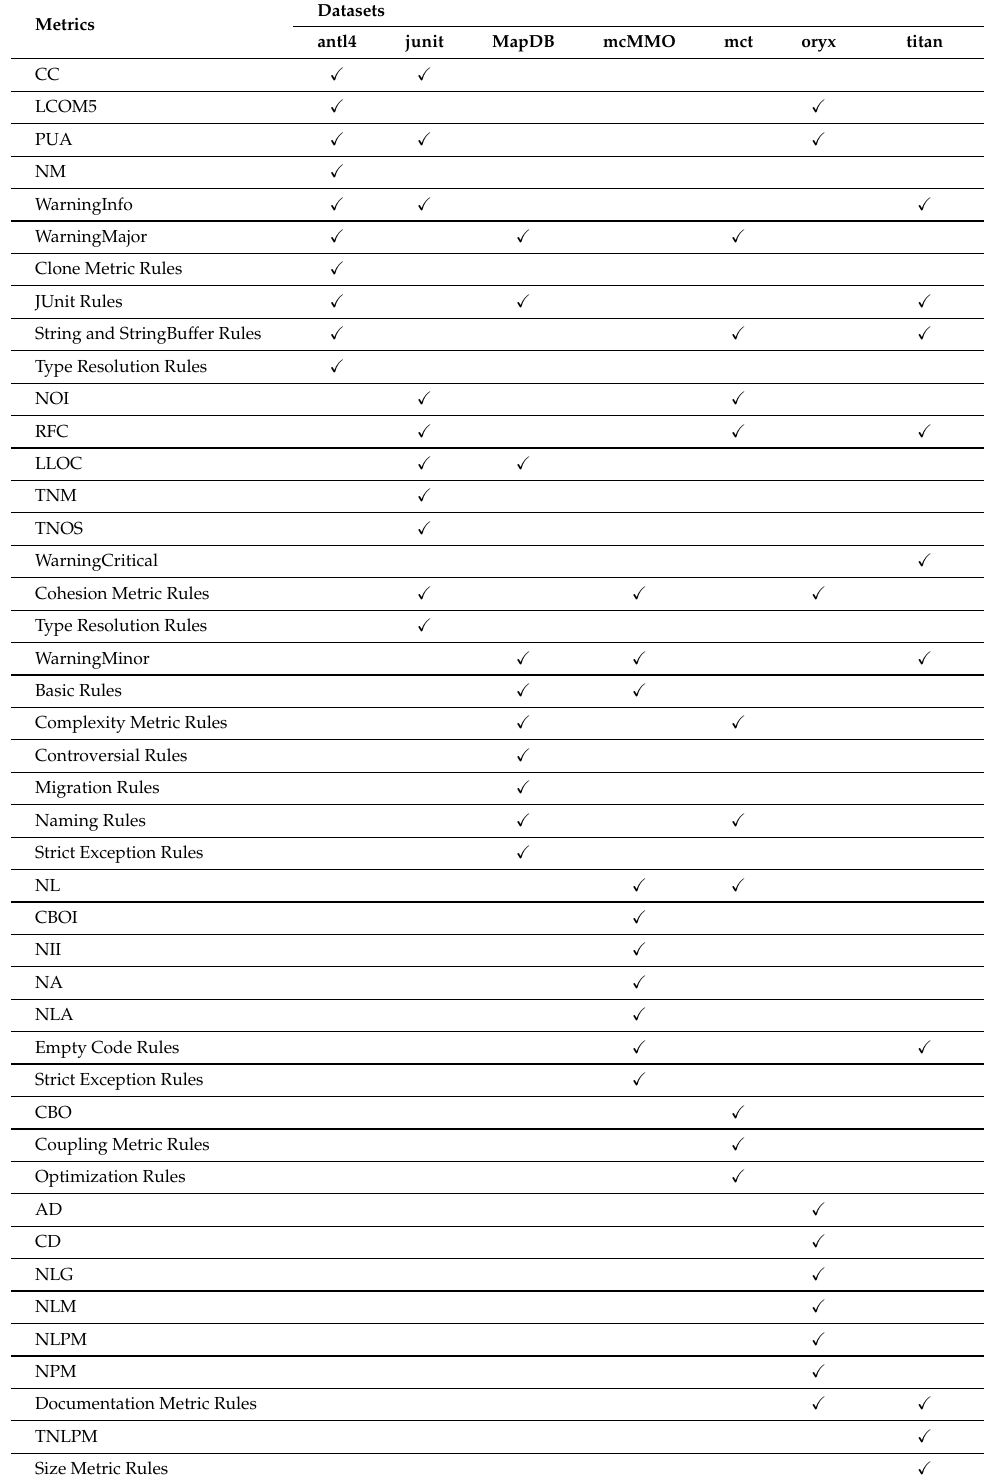
Table 9. Best ten metrics using ensemble FS